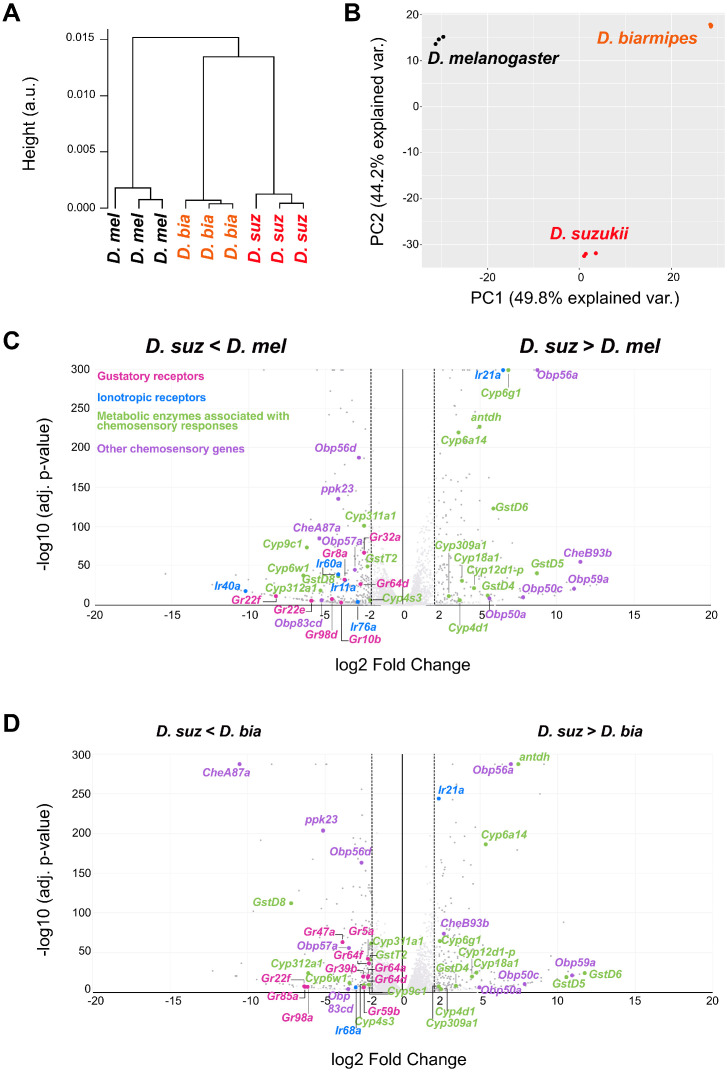
Distinct labellar transcriptomes across the Drosophila species.(A) Hierarchical clustering of the Drosophila melanogaster, Drosophila suzukii, and Drosophila biarmipes labellar transcriptomes. (B) Principal component analysis of the D. melanogaster, D. suzukii, and D. biarmipes labellar transcriptomes. (C) Volcano plot highlighting differentially expressed chemosensory-related genes between D. suzukii and D. melanogaster (|log2FC| ≥ 2, q < 0.01). All differentially expressed gustatory receptors (Grs) (pink) and ionotropic receptors (IRs) (blue) are labeled; metabolic enzymes (green) and other chemosensory genes (purple) are labeled only if differentially expressed between D. suzukii and both of the other species. We note that the genes indicated here belong to families of genes associated with chemosensation, but not all individual members have been implicated in chemoreception. (D) Volcano plot highlighting differentially expressed chemosensory-related genes between D. suzukii and D. biarmipes (|log2FC| ≥ 2, q < 0.01). For convenience of illustration we have plotted the log2 Fold Change but we note that in some cases, such as Gr22f and IR40a expression in D. suzukii, the expression level is extremely low, so that the fold-change is not informative.